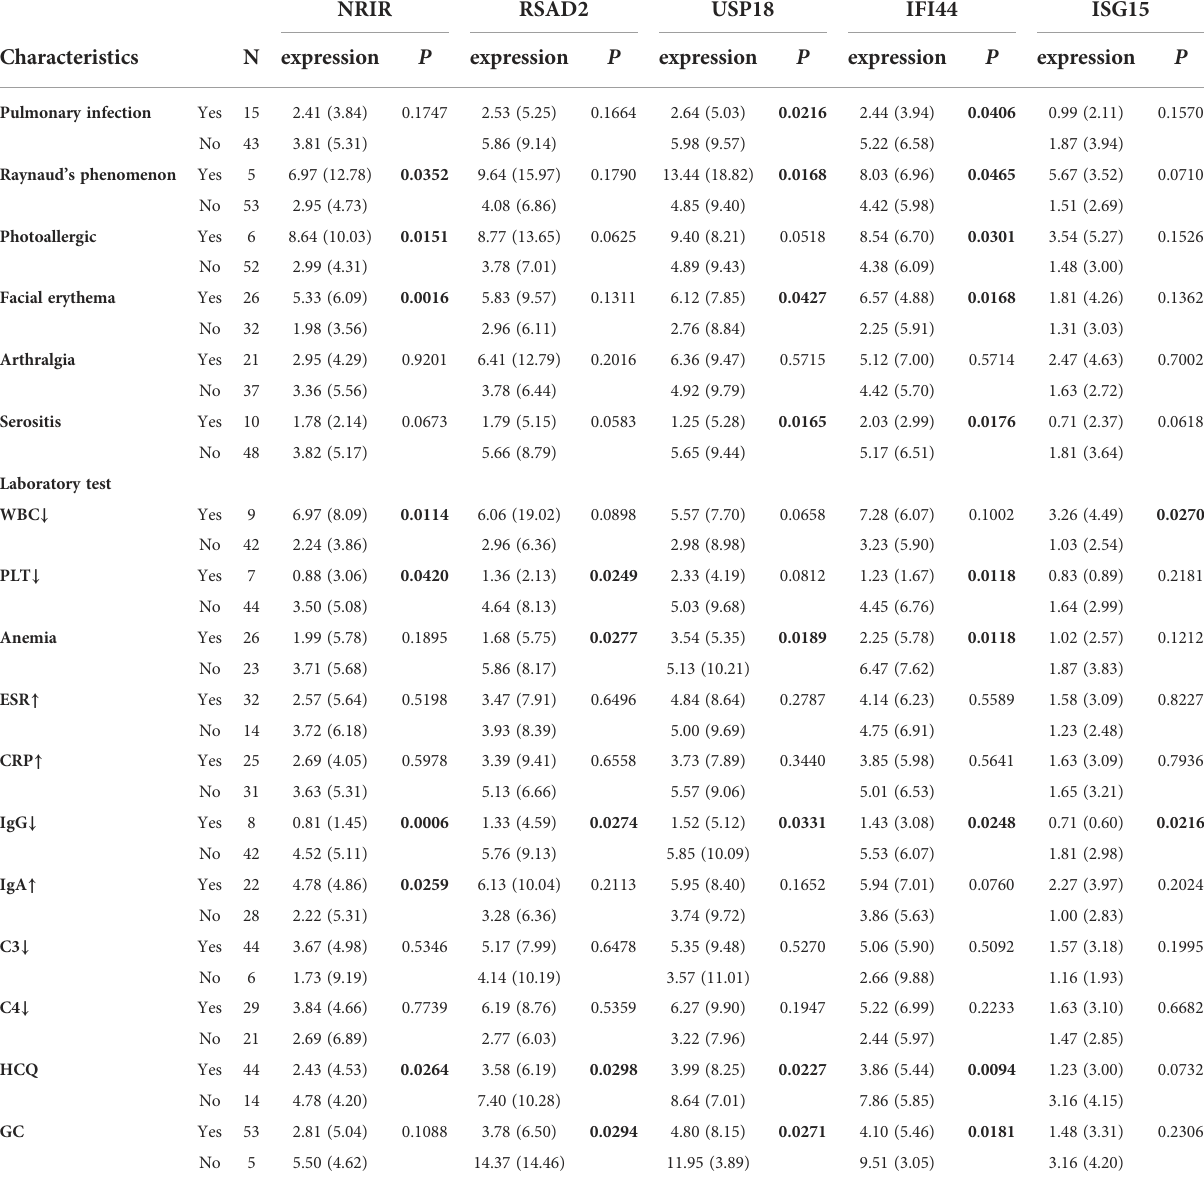
TABLE 4 The relationship of relative expressions of ISGs in PBMCs with the clinical characteristics of SLE patients. NRIR RSAD2 USP18